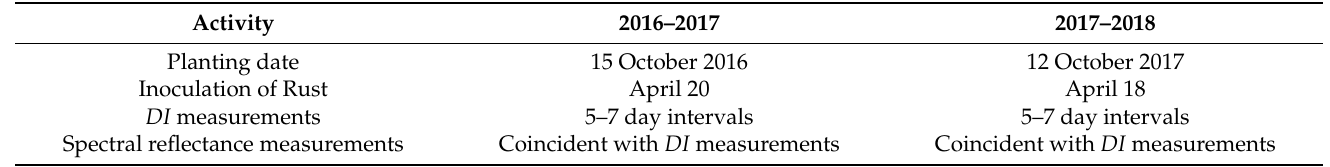
Table 2. Summary of field measurement activities for 2016–2017 and